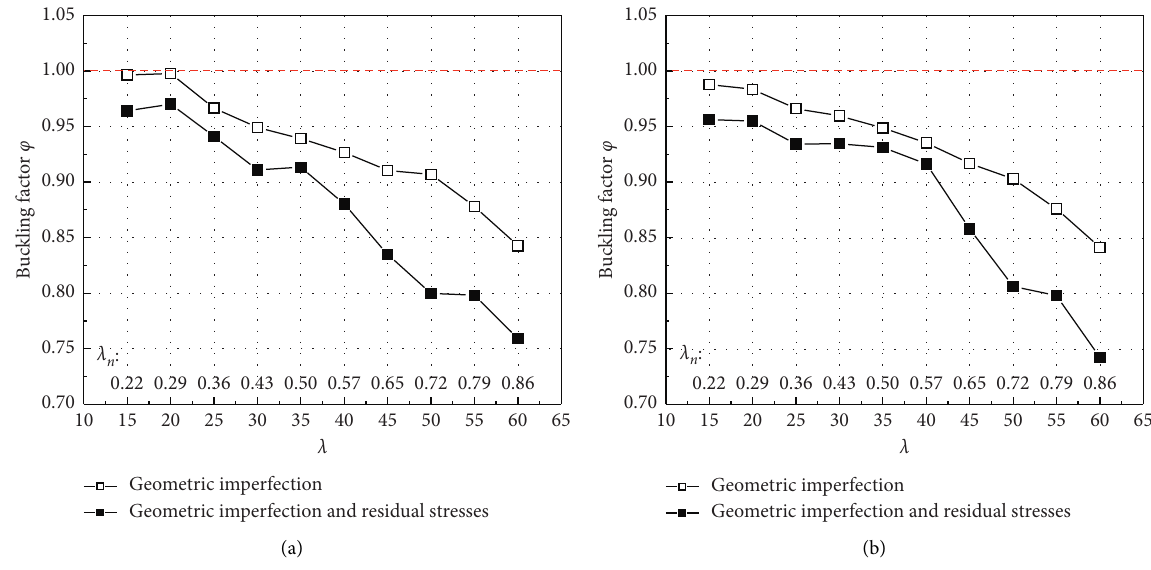
Figure 8: Comparison of the influence of residual stresses. (a) D159 × 6. (b) D508 × 8.